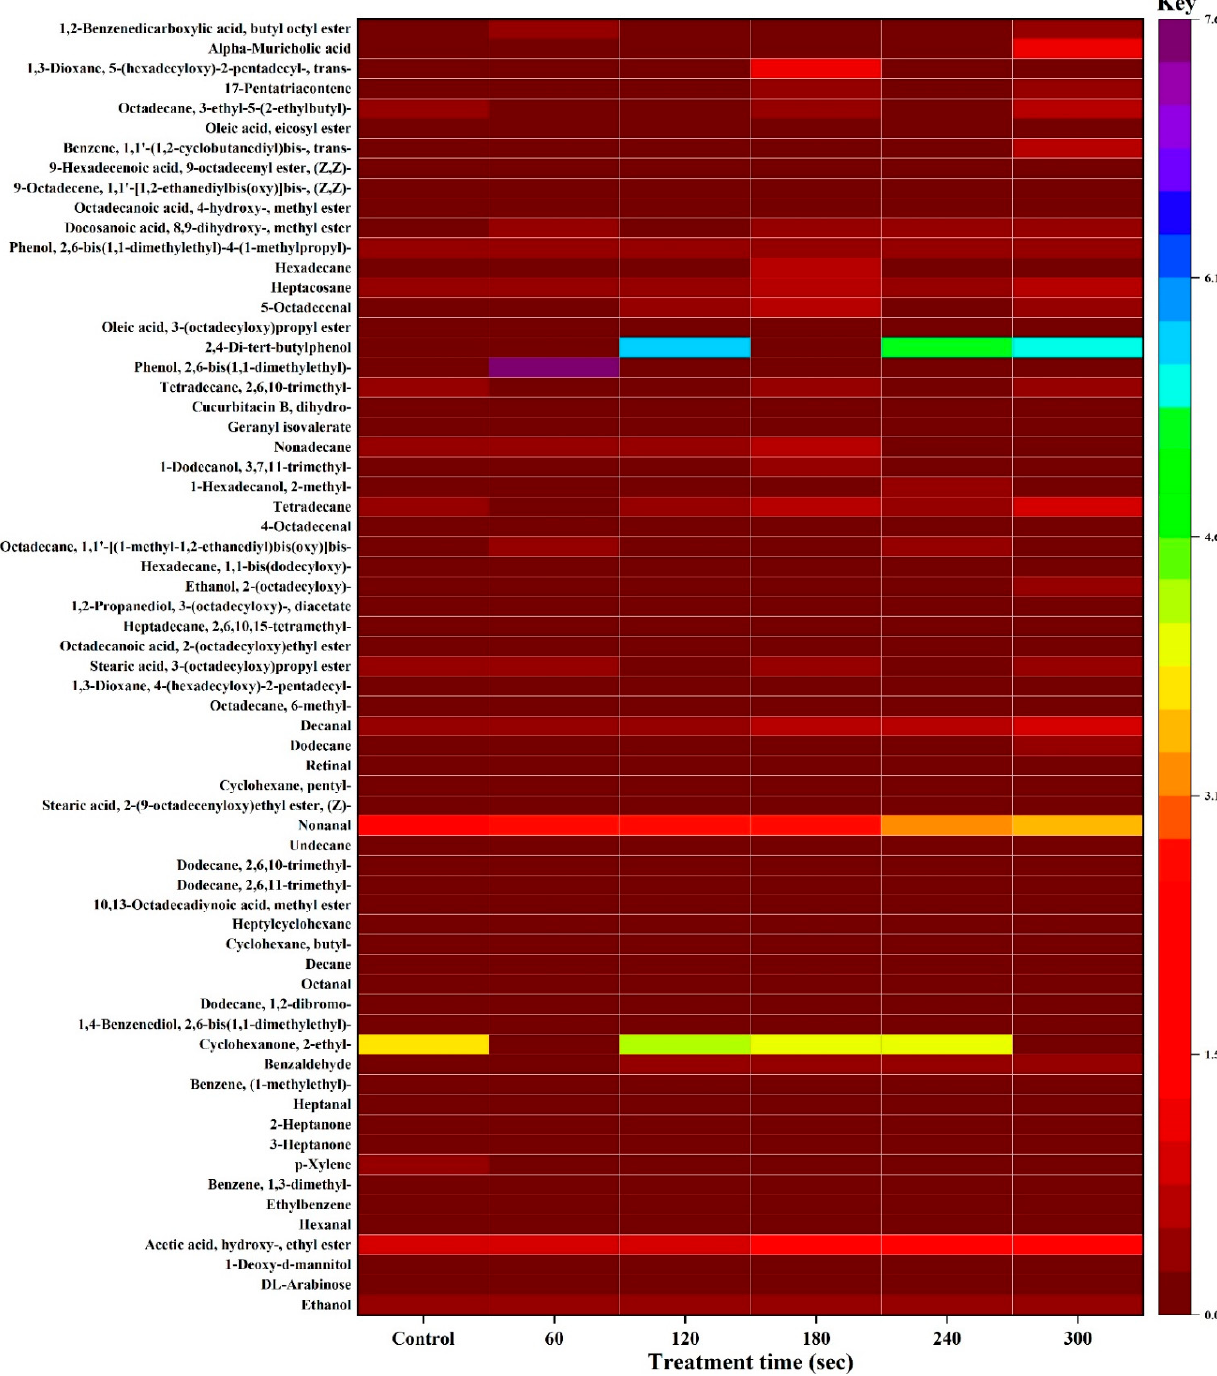
Figure 4. Heatmap showing individual concentration of volatile compounds identified in the HVCP-treated EWP at different treatment times.